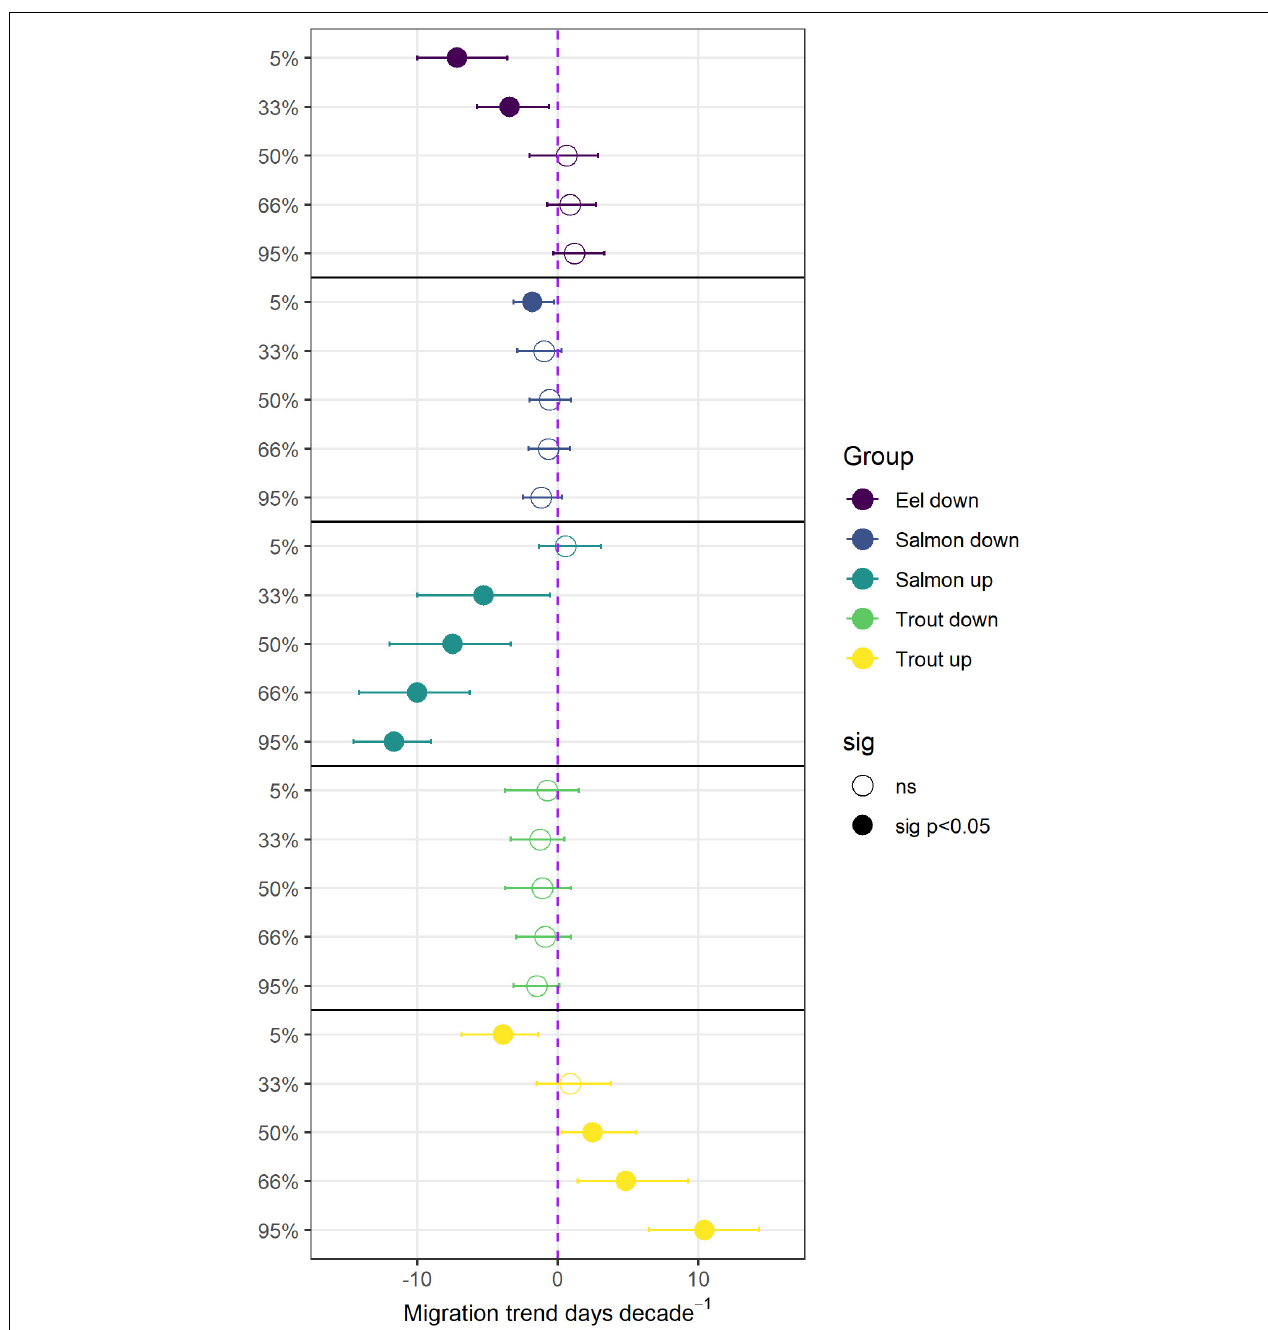
FIGURE 3 | Decadal trends in the migration of diadromous fish through the Burrishoole upstream and downstream traps. Dots are the Theil-Sens estimate of the trend (slope) for each variable, and error bars denote the 95% confidence intervals (c.i.) of the estimate. The dashed purple line indicates a slope of 0, i.e., no trend. Filled circles display a significant trend at p < 0.05 while open circles display a non-significant